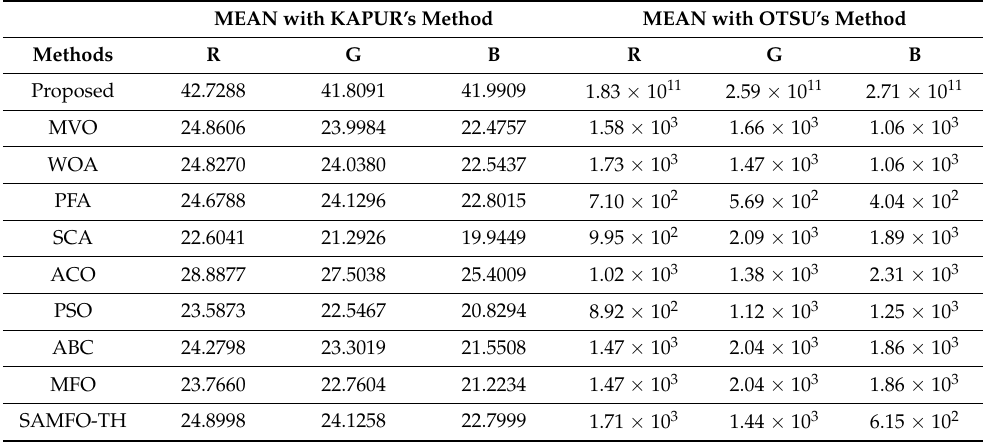
Table 17. Average MEAN of fitness with Kapur’s and Otsu’s methods on optimization techniques for MVO, WOA, PFA, SCA, ACO, PSO, ABC, MFO, and SAMFO-TH and on the proposed approach for nine images considered with N = 4, 6, 8, and